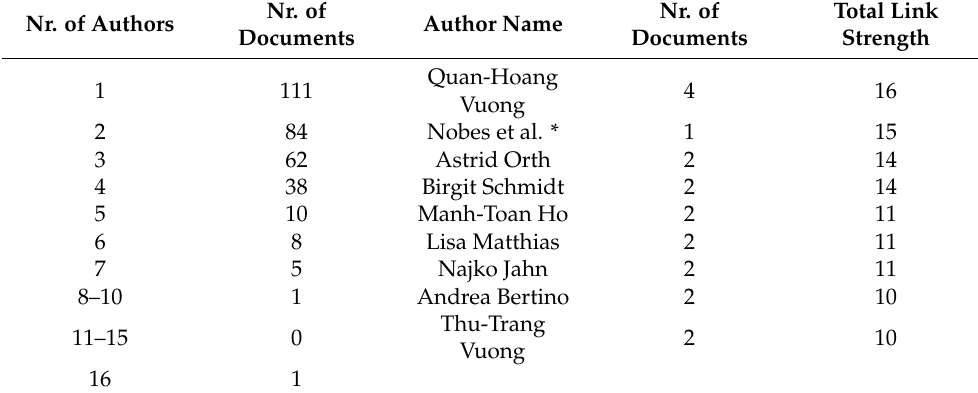
Figure 7. Author networks for both 5-year periods (n = 12 and n = 39, at least 2 documents). Node size indicates the total link strength. Source: VOSViewer.